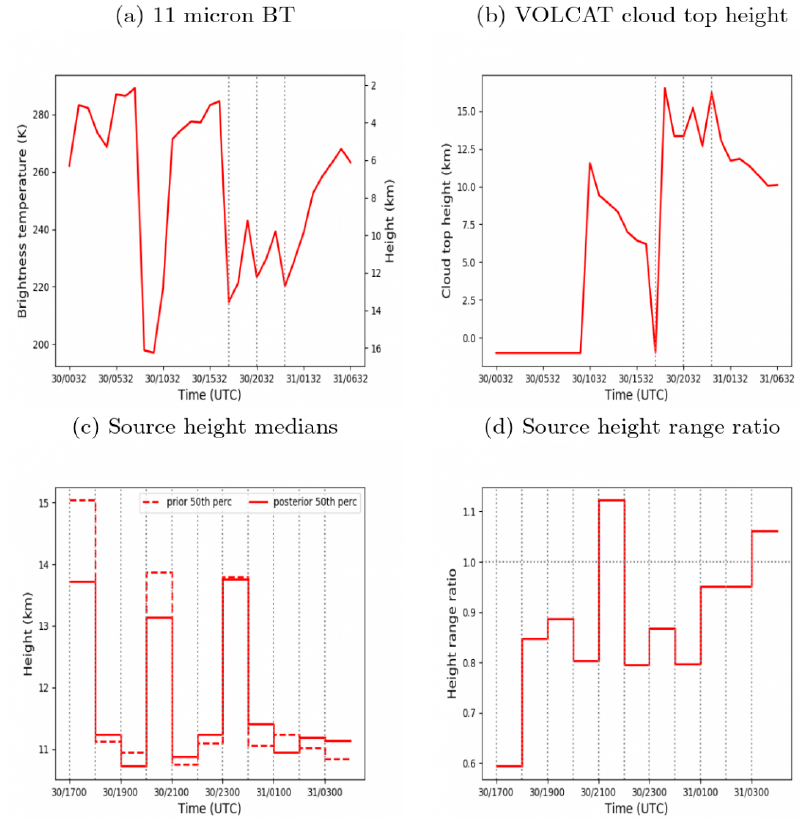
Figure 1. ( a ) Minimum satellite brightness temperature values in an approximately 1 ◦ × 1 ◦ box centered at the location of the Sangeang Api volcano. The vertical lines indicate times of interest, namely 1732, 2032, and 2332 UTC, at which significant eruptions occurred. ( b ) Same as in ( a ), but for maximum VOLCAT cloud top height field values. ( c ) Prior and posterior median (50th percentile) eruption heights as a function of time used in Experiment 1 of this study. ( d ) Ratio of posterior to prior source height ranges, defined as the difference between the 90th and 10th percentile heights in the respective distributions; ratios less than 1 indicate reduction in uncertainty.